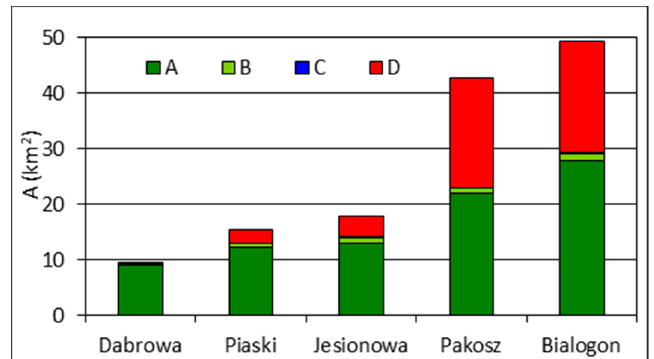
Figure 3. Areas that supply the Silnica channel with water and suspended solids. A —slopes and dry valleys, B —floodplains, C —direct supply to river channels, D —direct supply to river channels via anthropogenic drainage systems. Source: [41].